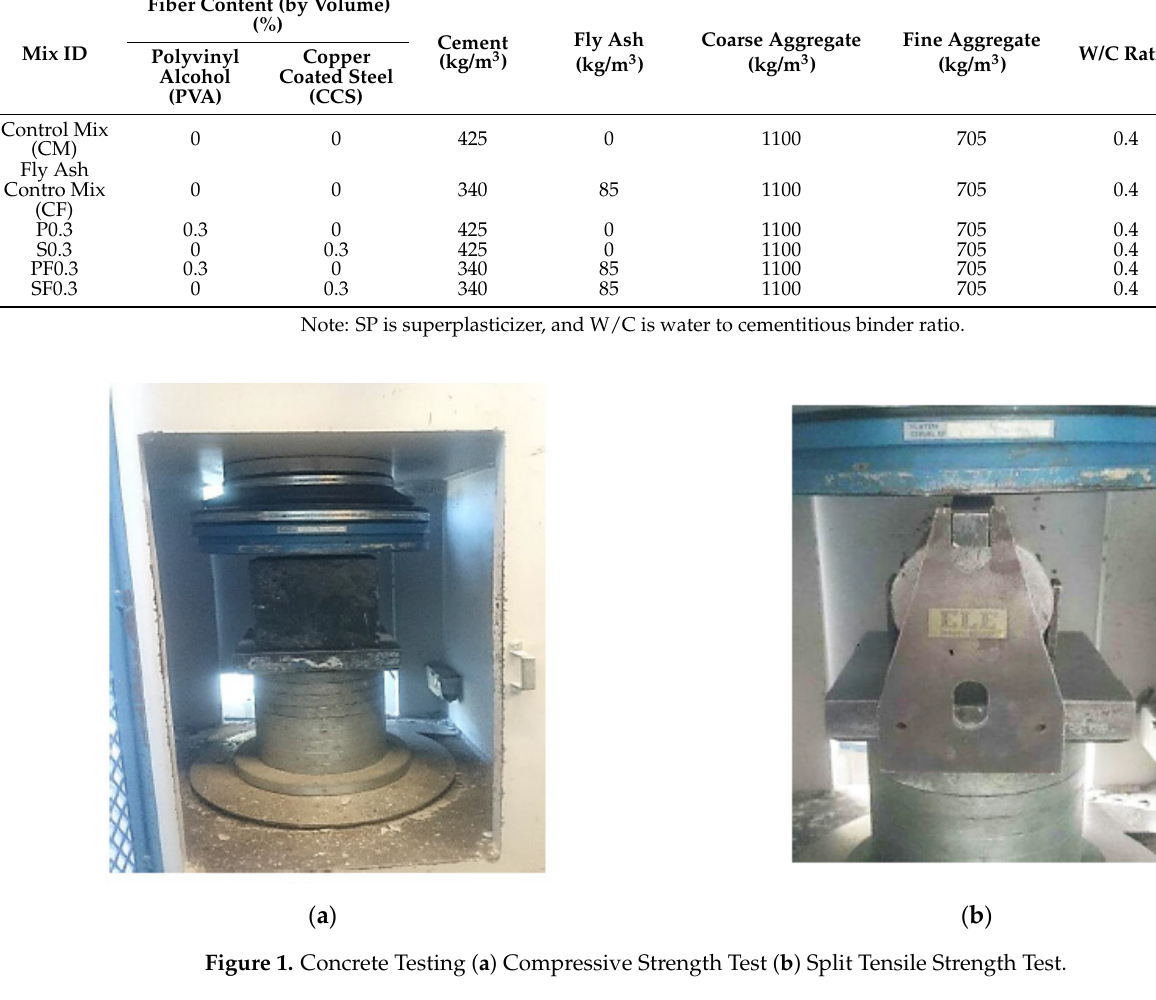
Figure 2. Four-Point Flexural Strength Test.